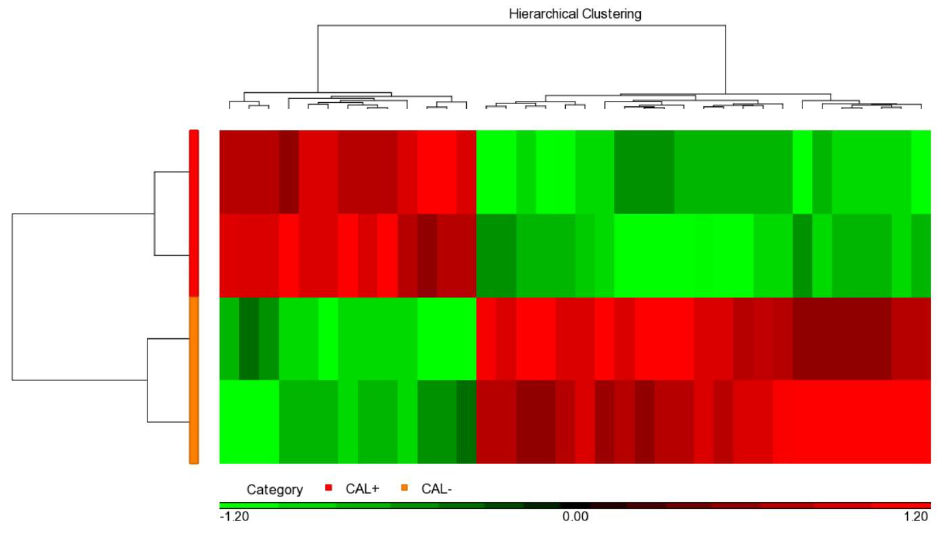
Figure 1. Heat map illustrated 36 significant serum proteins. Among the 846 proteins globally de- tected in two CAL+KD and two CAL − KD serum samples, 36 were significantly ( p -value < 0.05) and differentially abundant. The red and green pixels denote up-regulation and down-regulation in — — CAL+KD samples, respectively. CAL coronary artery lesion; KD Kawasaki